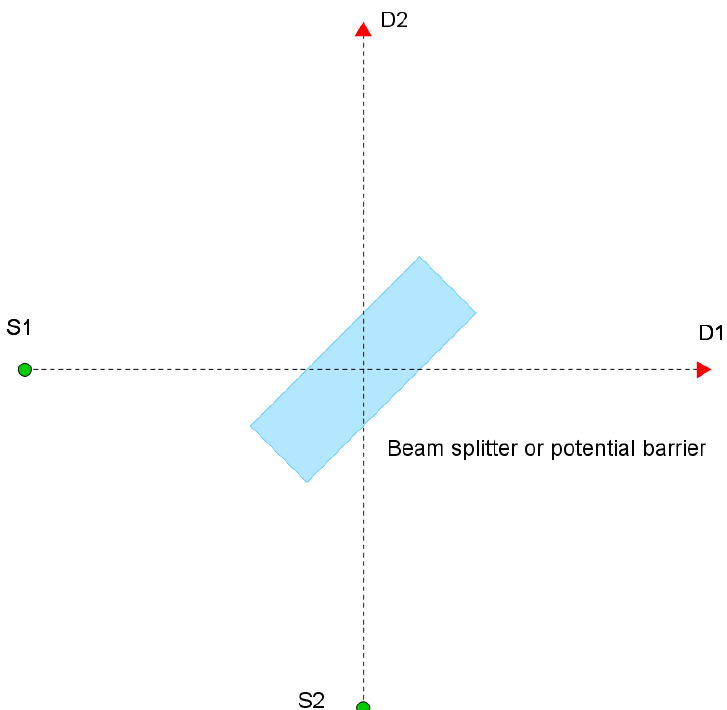
Figure 6. Setup of a generalized HOM (Hong-Ou-Mandel) experiment. Two sources (S1 and S2) emit simultaneously indistinguishable quantum objects (either photons or electrons), which are directed towards either a 50% beam splitter, or in the case of electrons, a potential barrier tailored to have 50% reflection and 50% transmission probability for the specific energy of the incoming electrons. The quantum objects may then be revealed at detectors D1 or D2.